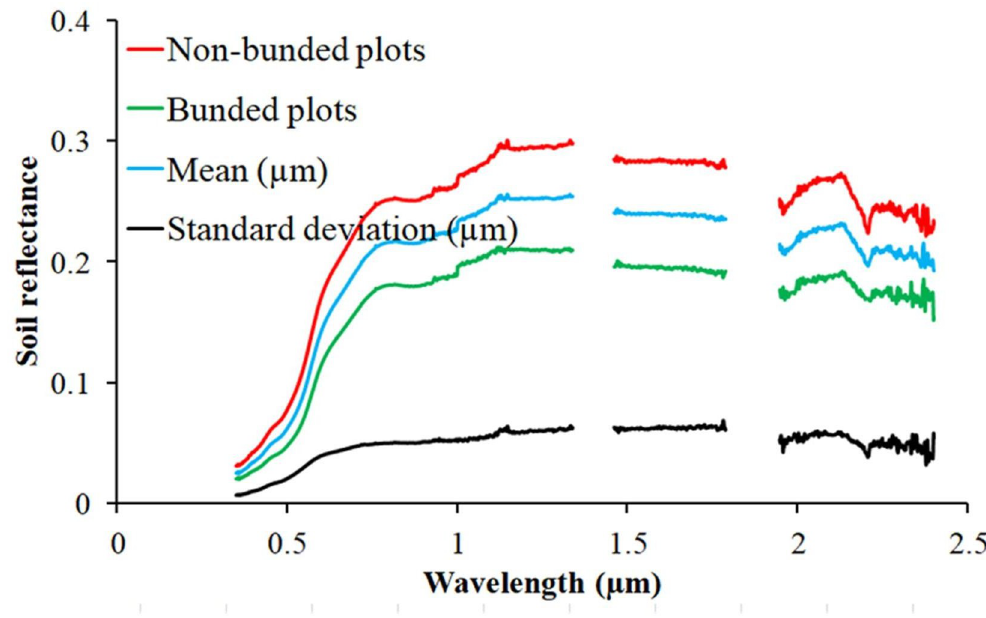
Fig 6. Soil reflectance spectra with and without